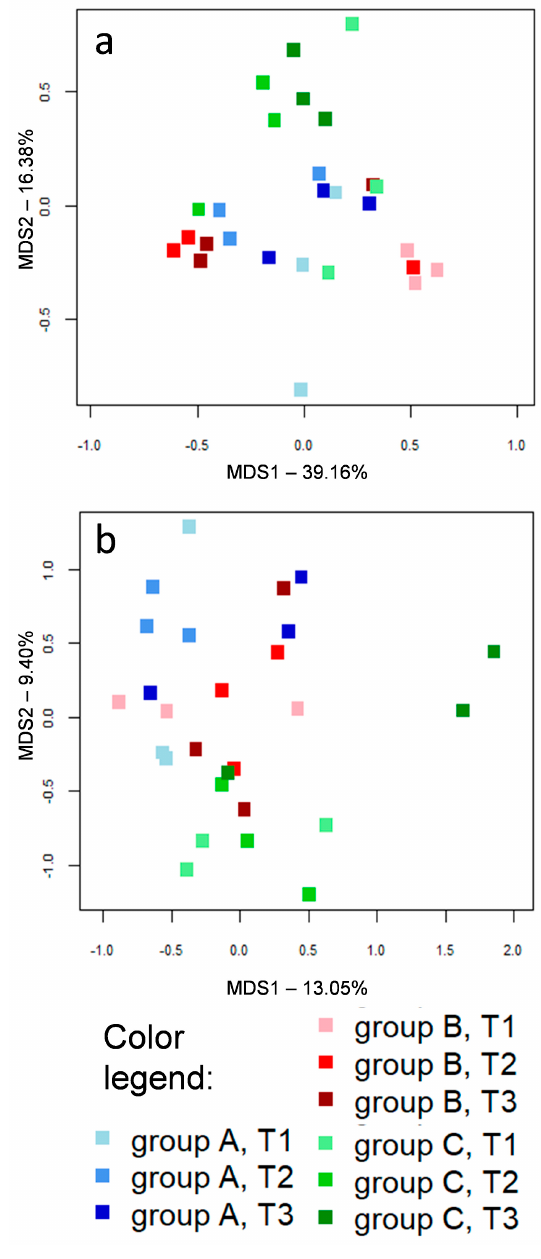
Figure 2. Principal coordinates analyses (PCoA) based on weighted ( a ) and unweighted ( b ) UniFrac distances of litter microbiota profiles in broilers in groups A (shades of blue), B (shades of red) and C (shades of green). Samples are depicted as squares filled in different shades of color, from light (earlier samples, day 15, T1) to dark (later samples, day 42, T3), according to the color legend provided at the bottom. First and second coordination axes are depicted in each plot; percentages of variation in the datasets explained by each axis are reported.